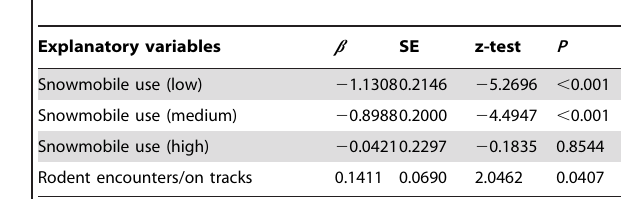
Table 4. Results pertaining to the best performing beta regression mixed models for the effects of various covariates of interest (e.g., snowmobile use, rodent track encounters) on the amount of time coyotes spend on snowmobile trails (i.e.,%Track), northwestern, Wyoming,